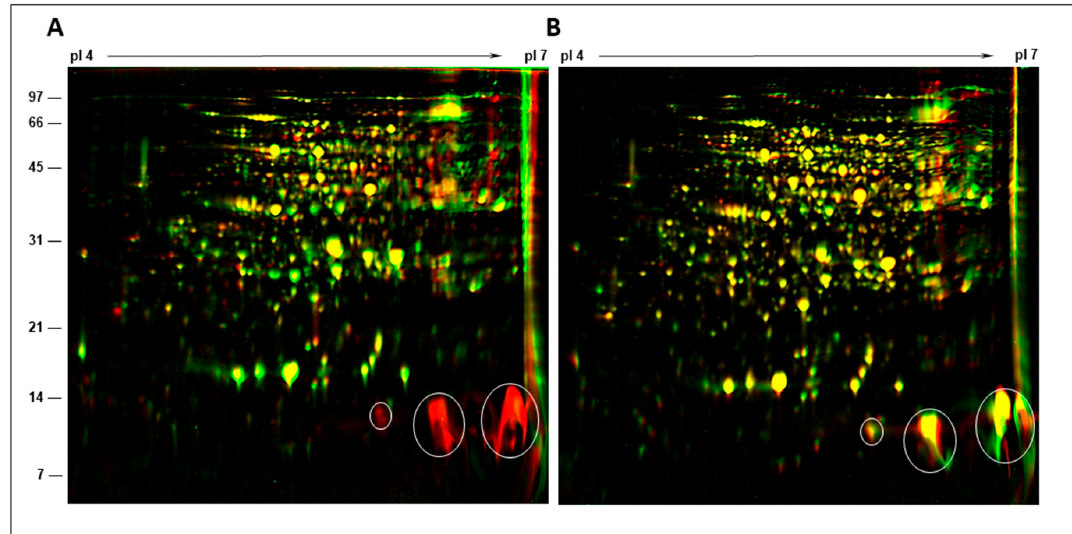
Figure 8. Comparison of nodule cytosol proteins by 2-D gel electrophoresis. Cytosol proteins isolated from 30-day-old pigeon pea nodules initiated by B. diazoefficiens USDA110 (green color), B. diazoefficiens ∆ 136 (red color) ( A ), S. fredii USDA191 (green color), and S. fredii RCB26 (red color) ( B ) were separated by isoelectric focusing (pH 4 to 7) followed by SDS-PAGE on a 15% gel. The proteins were visualized by staining the gel with Colloidal Comassie Blue G-250. These gels were scanned and proteins from wild type were assigned green color and those from T3SS mutants were given red color. The gels were overlaid using Delta2D software to detect protein differences. Yellow represents equal amounts of protein, red indicates lower abundance of a specific protein in wild type formed nodule and green color points to an increase in the abundance of protein in the T3SS mutant induced nodules. Leghemoglobulin protein spots are circled. The sizes of molecular weight markers in kDa are shown on the left side of the figure.